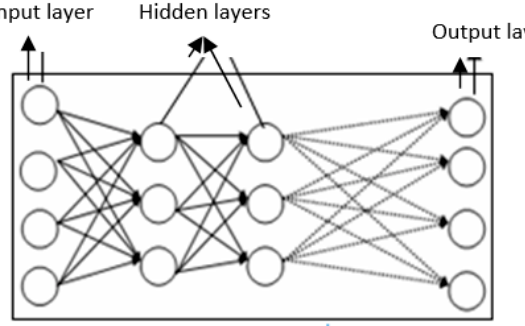
Figure 1. The general structure of a feedforward network.